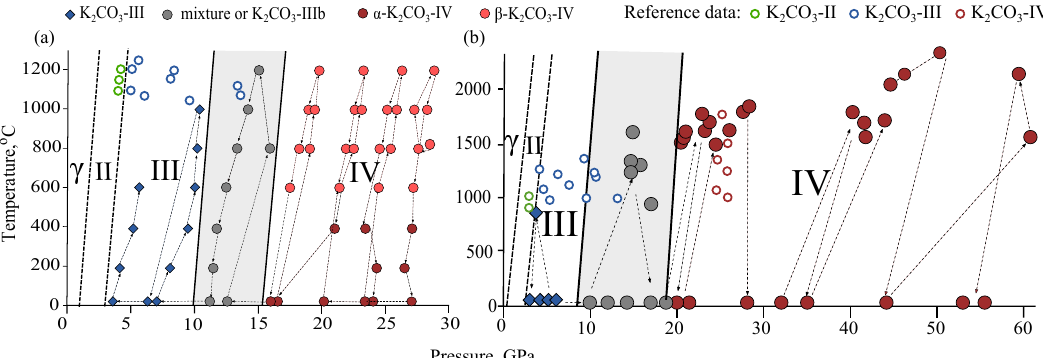
Figure 6. Phase diagrams of K 2 CO 3 from MA ( a ) and DAC-APS ( b ) experiments. Empty circles-reference the data of Li [24].